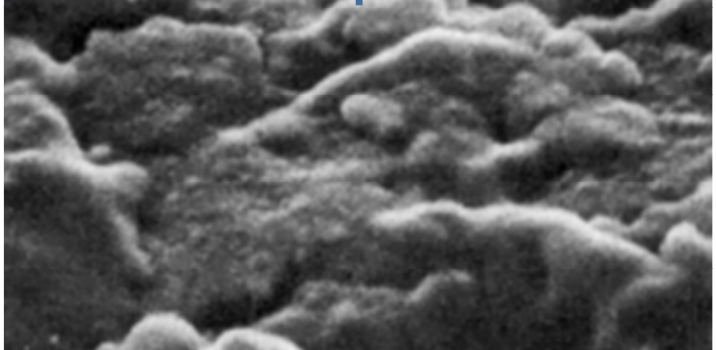
Figure 1. Cyclic voltammograms of 1×10 -3 mol L -1 oAP in 1 mol L -1 HClO completed after 95 cycles.